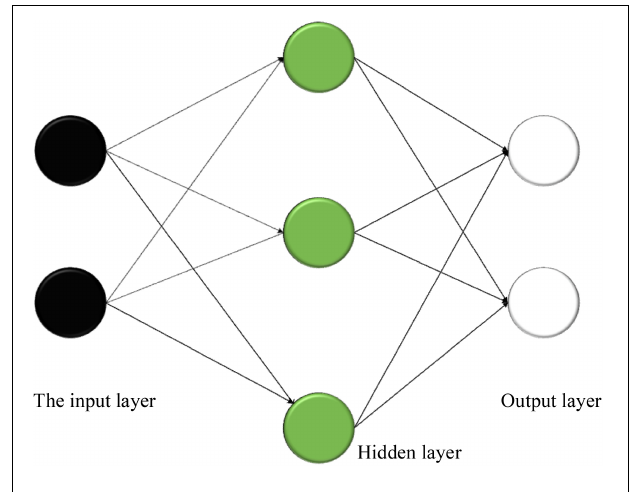
FIGURE 3 | Structure of